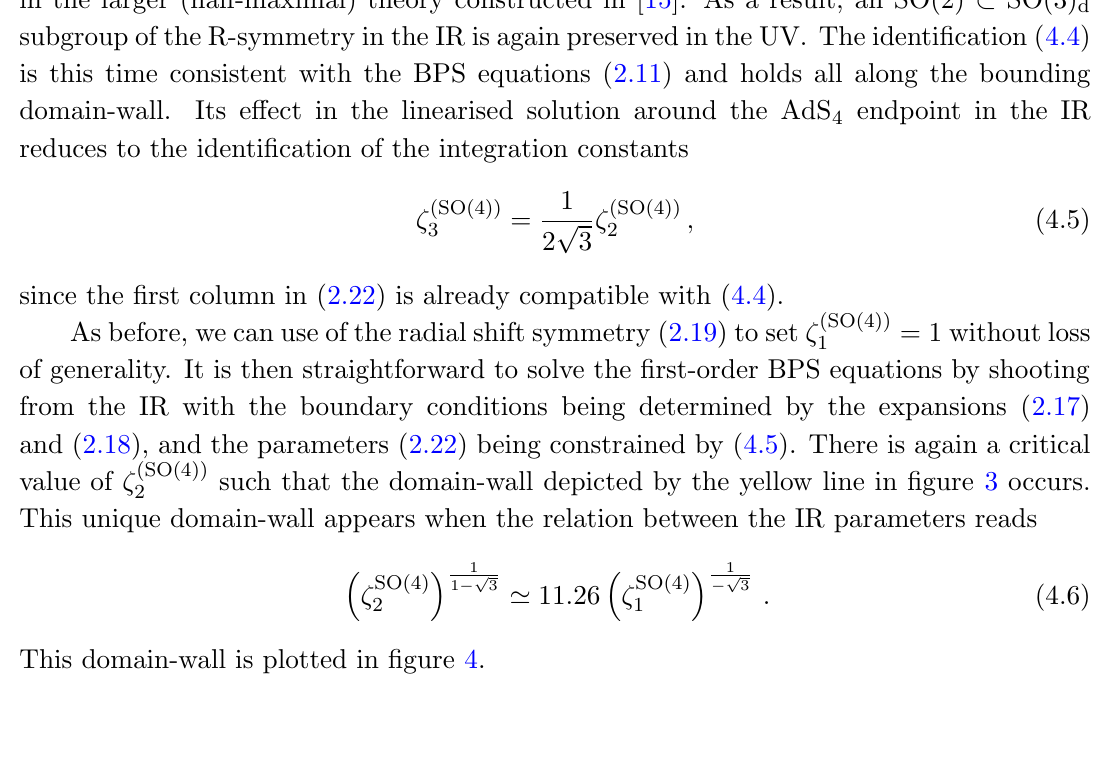
2 = (cid:16) (SO(4)) that passes 3 2 5 (cid:0)